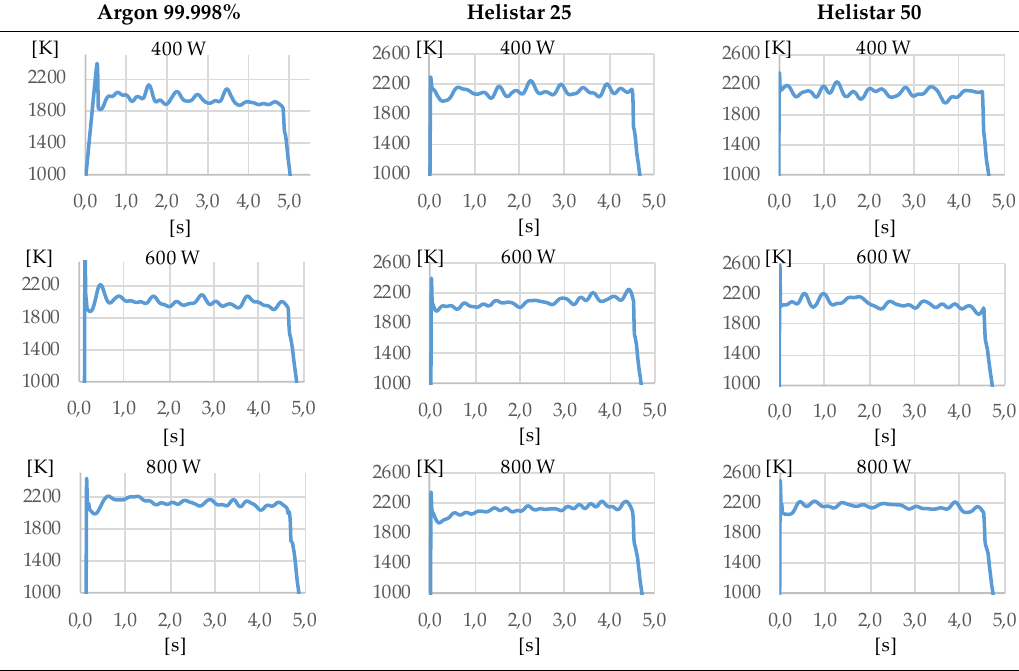
Table 11. Summary of results for experimental tests at 400 W, 600 W, and 800 W.